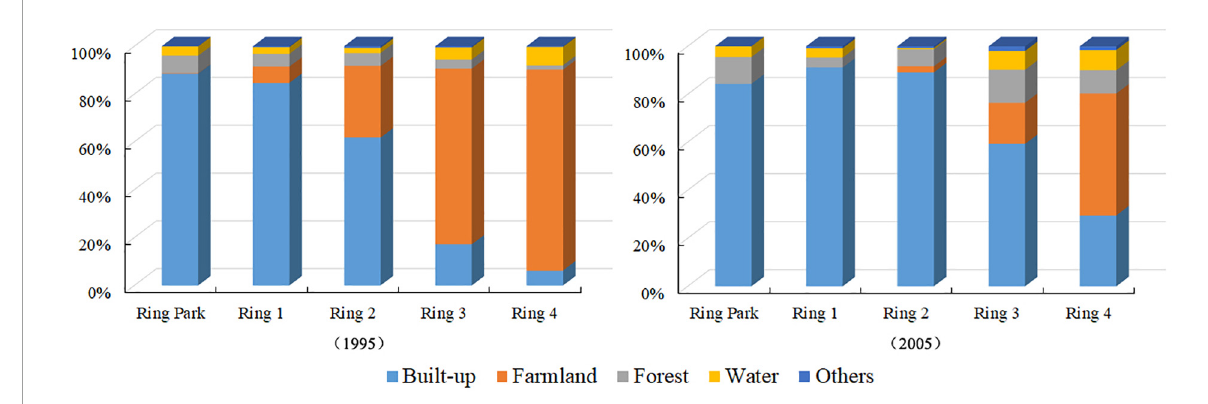
FIGURE5 Schematic diagram of the proportion of green space in different rings.